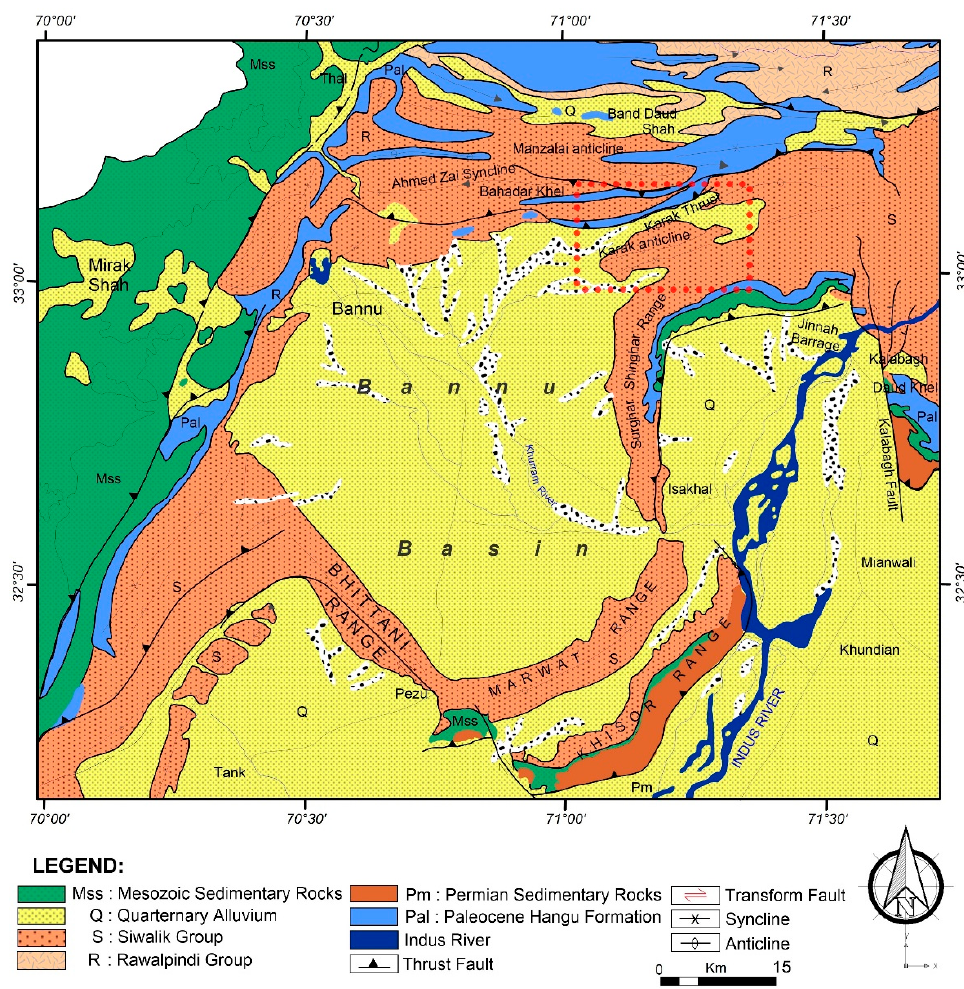
Figure 2. Regional geology map of the study area illustrates main structural and lithological units.